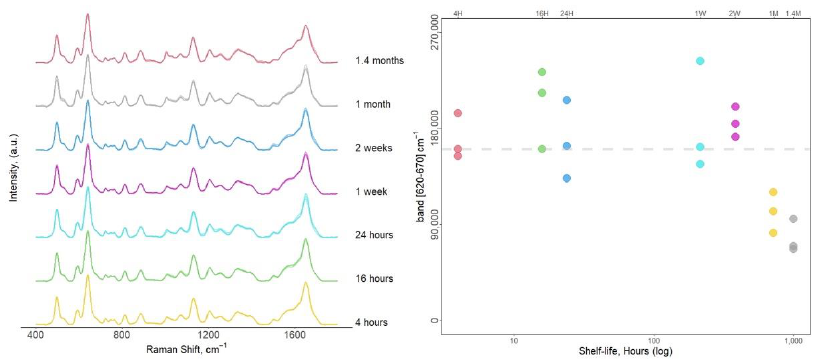
Figure 6. Shelf life evaluation from serum-soaked strips for the CSPP sampling protocol. ( a ) Nor- malized SERS spectra; ( b ) absolute intensity distribution at 640 cm −1 band corresponding to the different times reported in (a). The average intensity of the first time point is marked with a dashed line for comparison.